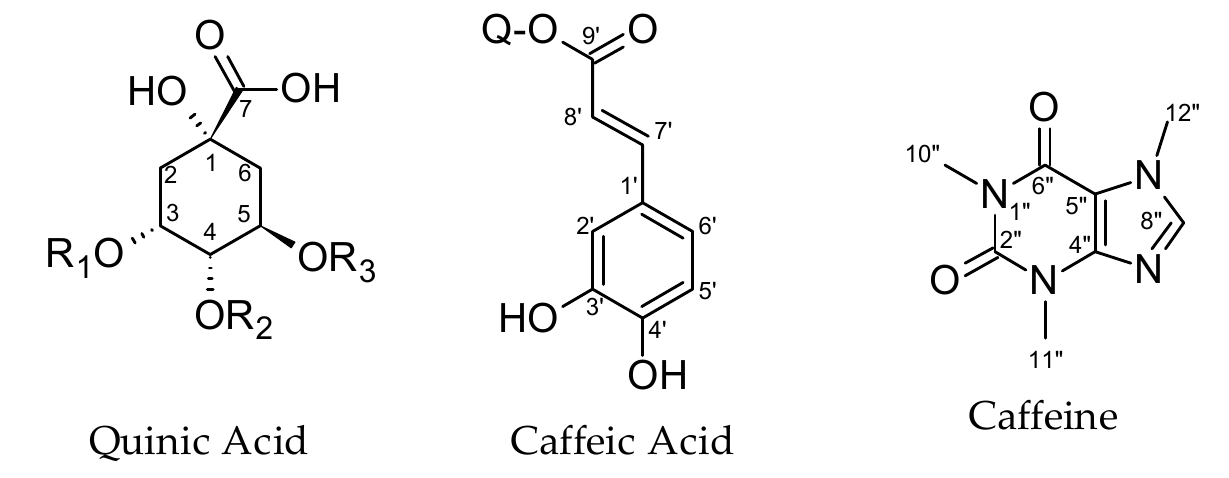
Figure 1. Carbon and proton positions utilized in the NMR spectrum annotations showing the chlorogenic acids utilized in this study of individual chlorogenic acid interactions as well as complex mixture interactions with caffeine.